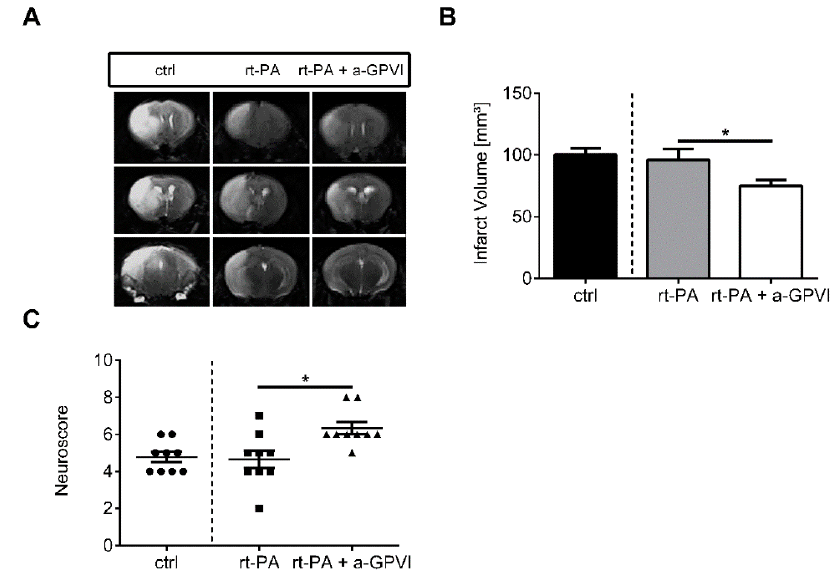
Figure 2. Blocking of glycoprotein VI (GPVI) mediated collagen binding together with rt-PA treatment improves stroke outcome in a transient middle cerebral artery occlusion (tMCAO) model.